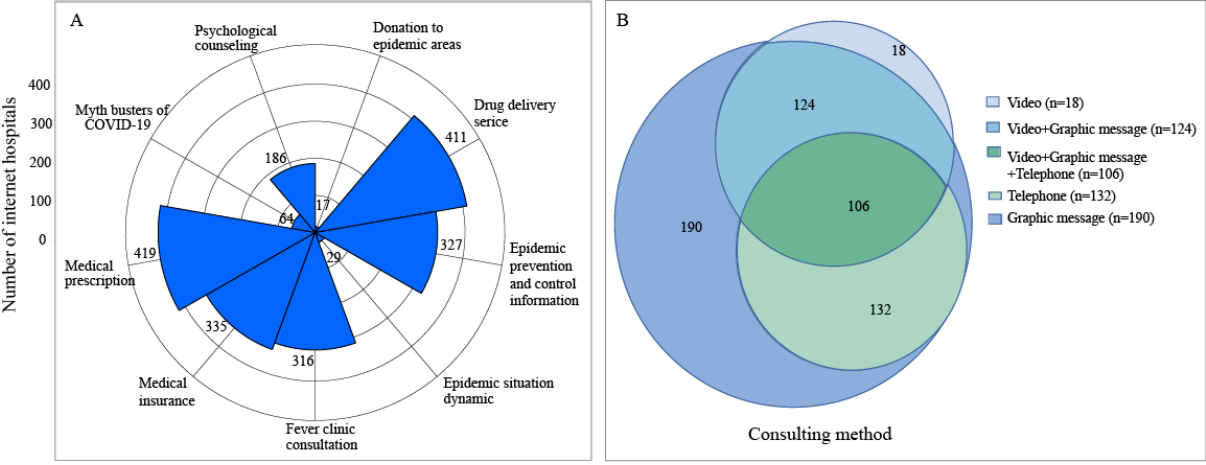
Figure 5. Medical service characteristics of China’s internet hospitals. (A) The roles that internet hospitals played in fighting COVID-19. (B) Internet hospitals’consulting methods.